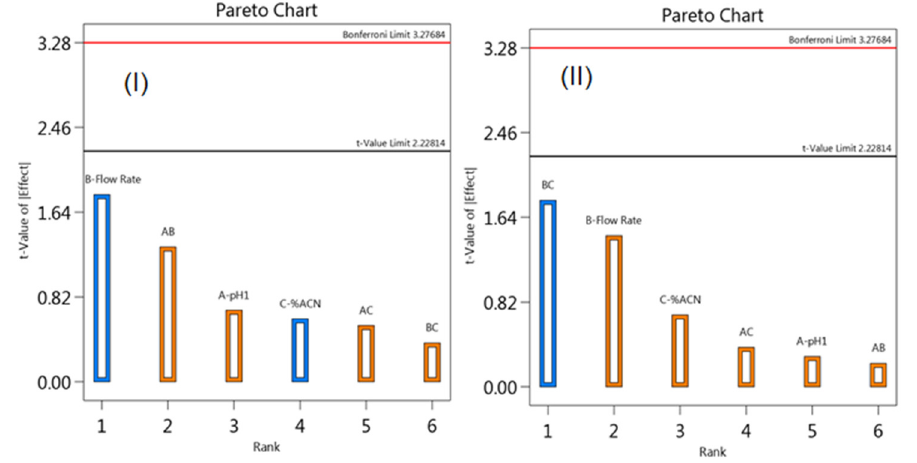
Figure 10. Pareto Chart showing the effects of percent of SDS (A), percent of acetonitrile (B) and pH of the mobile phase (C) on the resolution of MFH to RGE ( I ) and RGE to IS ( II